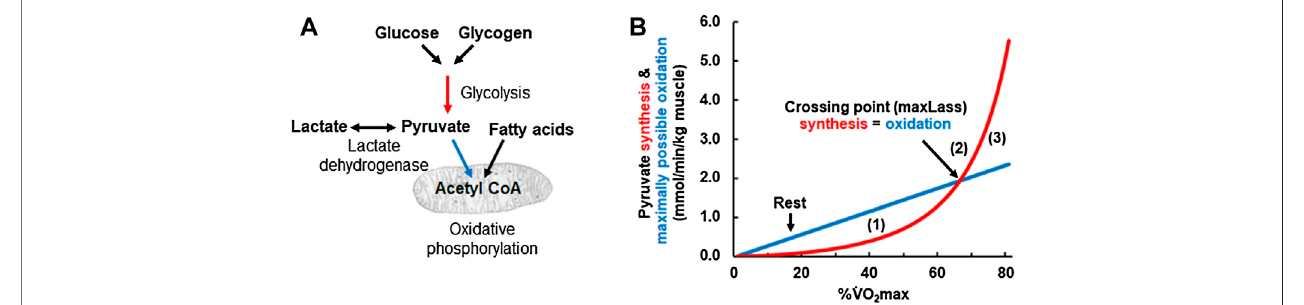
FIGURE3|(A) SchematicdrawingofthepathwayssimulatedinPanel3 (B) .RedarrowreferstoglycolyticATPresynthesisorpyruvatesynthesis,theglycolytic fl ux rate ν La. The blue arrows refer to the oxidative ATP resynthesis or the maximally possible rate of pyruvate oxidation, the oxidative fl ux (V _ O 2 ). (B) Calculated glycolytic pyruvate (and lactate) synthesis [red arrow in (A) and red line in (B) ] and maximally possible rate of pyruvate (and lactate) oxidation at different exercise intensities expressed asapercentage ofthe _ VO 2max .(1)isthezone whereglycolyticpyruvate synthesisisbelowthemaximallypossiblerateofpyruvateoxidationbyoxidative phosphorylation. In this area, the pyruvate de fi cit allows either fat oxidationto fuelthe substrate demand of oxidative metabolism or the uptake ofpyruvate via previously accumulated lactate. Point (2) is the crossing point where glycolytic pyruvate and lactate synthesis match the maximally possible rate of pyruvate oxidation at a given workload.ThispointindicatesthemaxLass.Incontrast,(3)isthezoneglycolytic fl uxandtheresultingpyruvatesynthesisexceedsthemaximallypossiblerateofpyruvate oxidation. As a consequence, pyruvate and lactate